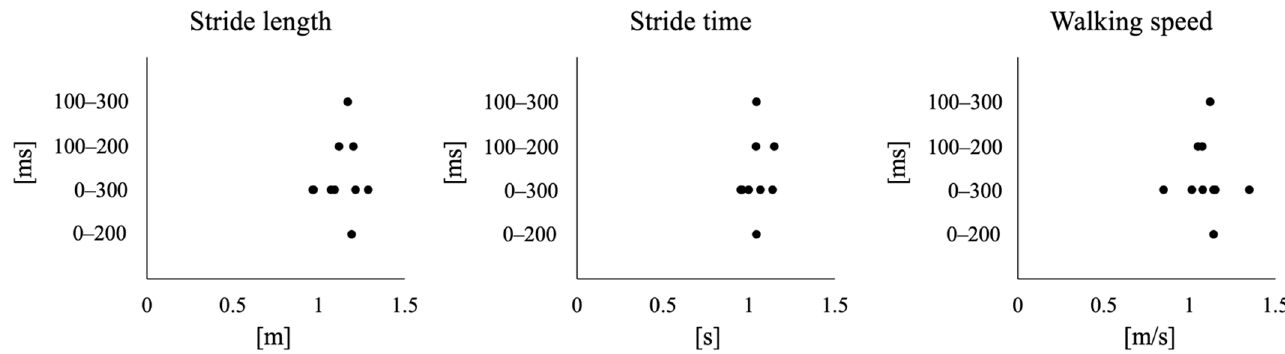
Figure 6. Scatter plots of walking performance and optimal parameter setting for each participant. The vertical axis indicates the combinations of delay–contraction duration as the effective parameter setting.